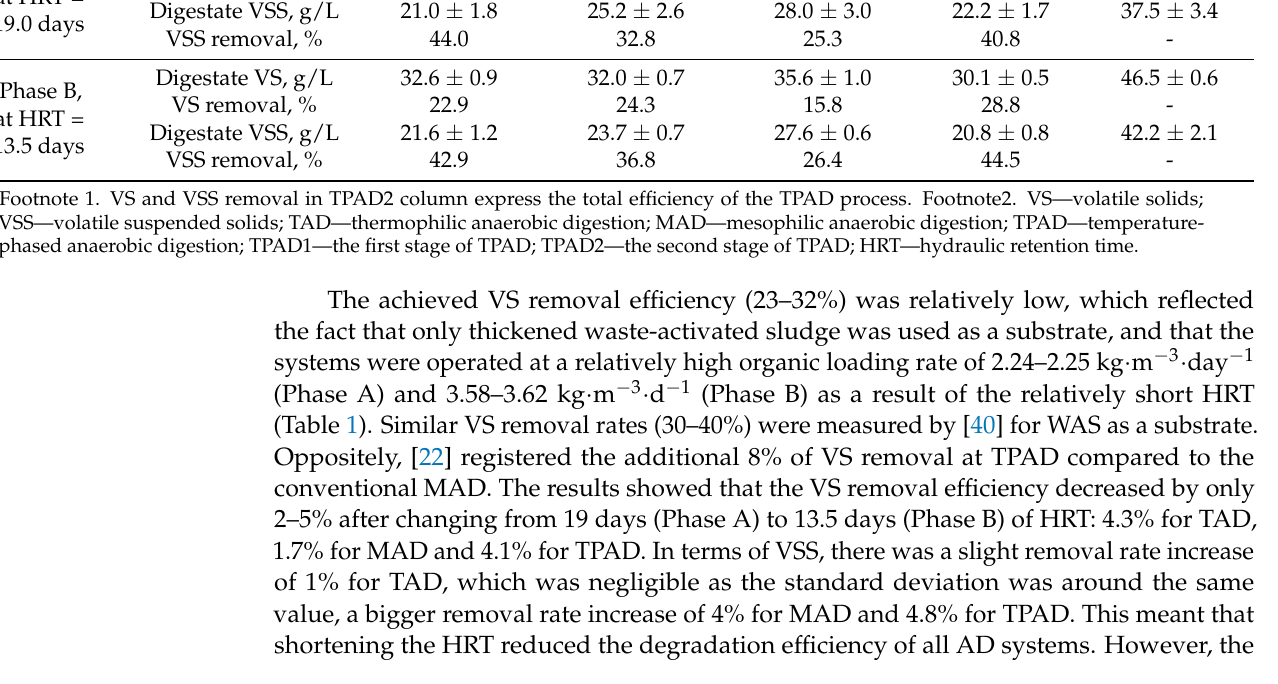
Table 2. Organic matter removal in the mesophilic, thermophilic and temperature-phased anaerobic digestion systems. Phase